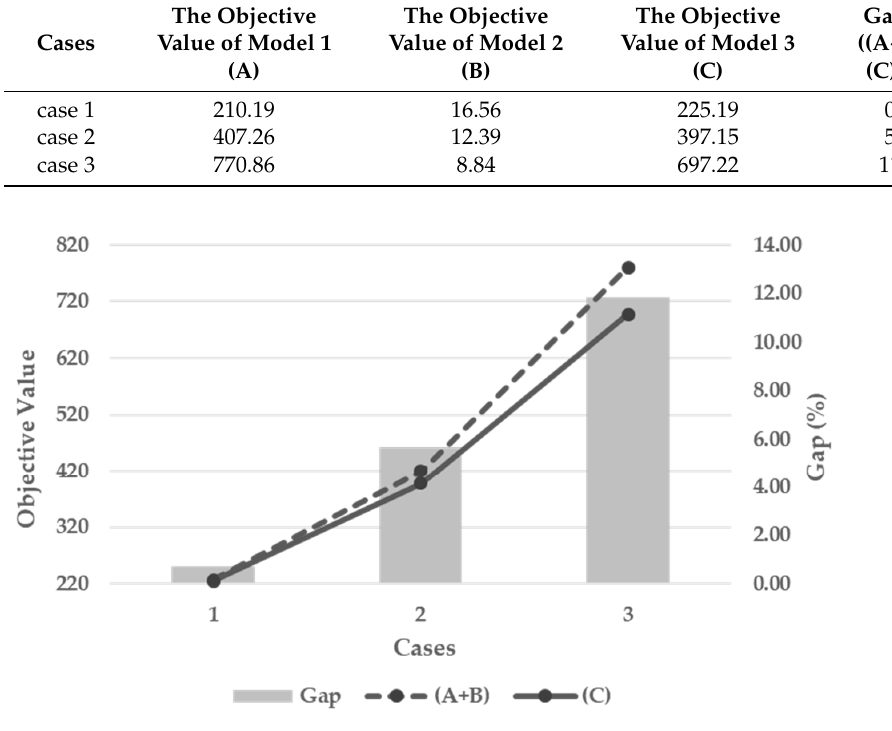
Figure 6. Comparison of experimental results for the change in the number of transport companies (forwarders).